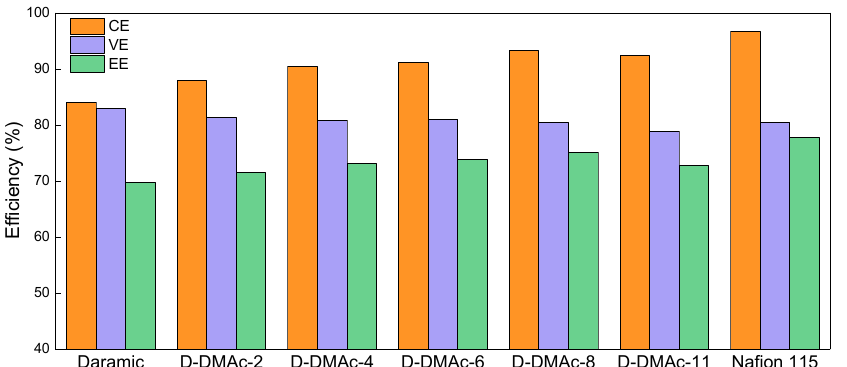
10 of 15 Figure 6. ( a ) Water uptake (WU); ( b ) Contact angle; and ( c ) Iron ion permeability and area resistance of D ‐ DMAc ‐ x membranes. 3.4. ICFB Battery Performance ICFBs with D ‐ DMAc ‐ x (x = 0~11) membranes were assembled to evaluate the effects of the Nafion resin amount. Compared with Daramic membrane, a drastic increase in CE (from 84.05% to 93.29%, at the current density of 80 mA cm − 2 ) is achieved by the coating of Nafion resin (Figure 7). Besides, CEs of ICFBs with D ‐ DMAc ‐ x membranes first rise with the rising Nafion resin amount and then reach a stable value, which is in accordance with the Fe 3+ permeability. Luckily, except for D ‐ DMAc ‐ 11, the change in VEs of ICFBs